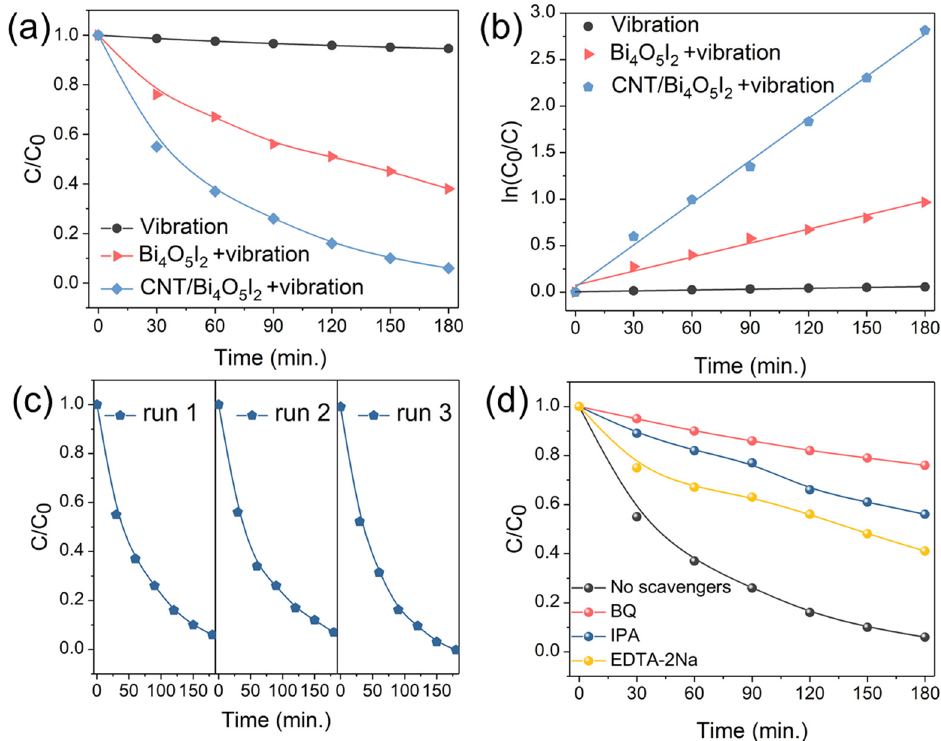
Figure 4. ( a ) Piezocatalytic performances of the pure Bi 4 O 5 I 2 and 15% CNT/Bi 4 O 5 I 2 composite on the degradation of RhB under ultrasonic vibration; ( b ) the corresponding k values of first-order kinetics plot of Bi 4 O 5 I 2 and CNT/Bi 4 O 5 I 2 composite; ( c ) cycling runs of RhB degradation by CNT/Bi 4 O 5 I 2 ; ( d ) scavenger trapping experiments of CNT/Bi 4 O 5 I 2 on the degradation of RhB under ultrasonic vibration.